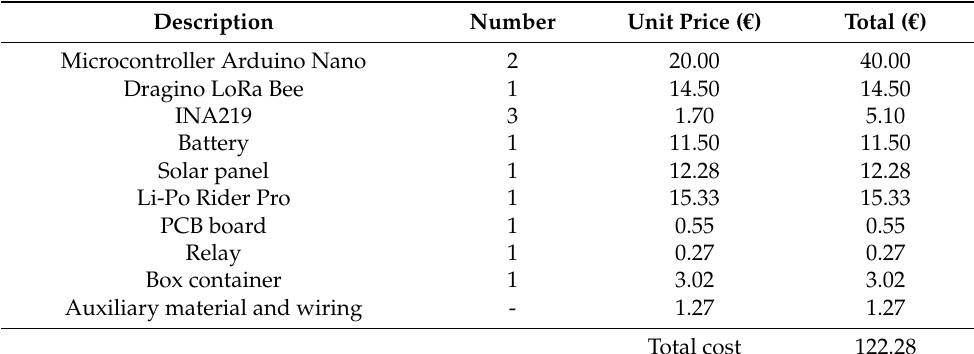
Table 10. Cost of components for the ECDL with a battery and solar panel power